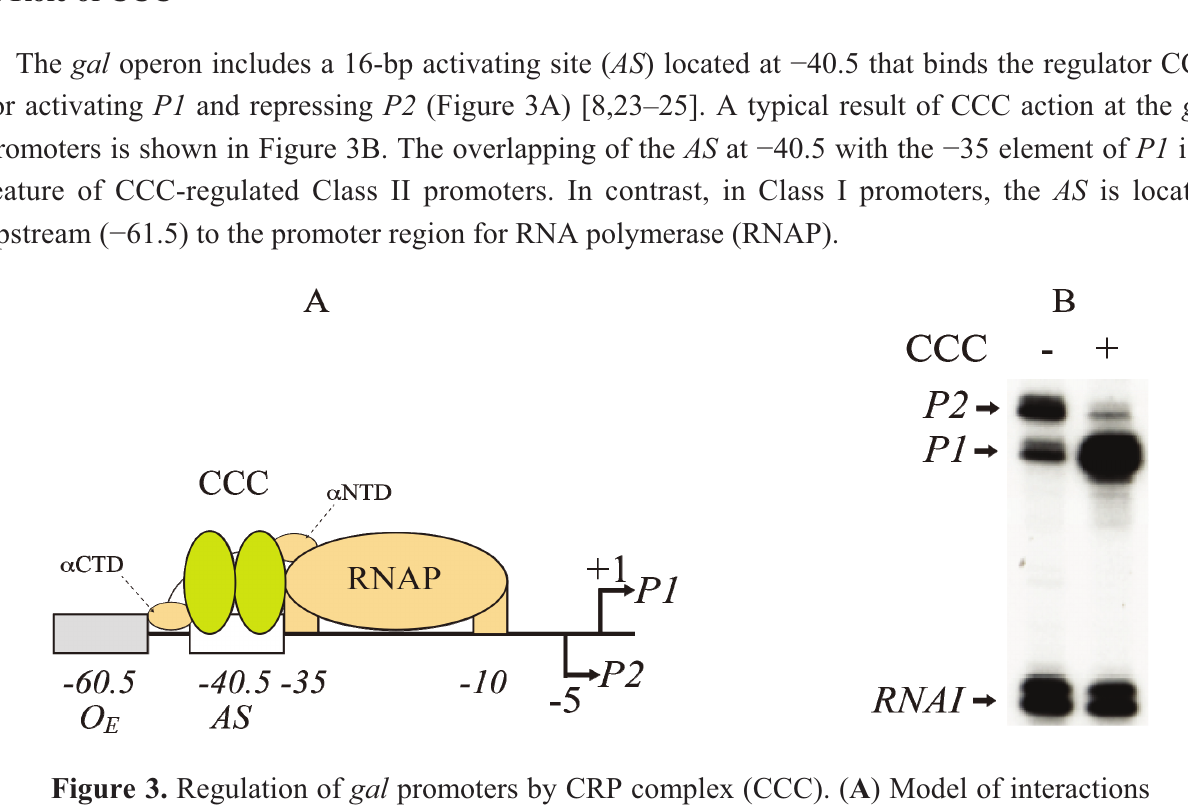
Figure 3. Regulation of gal promoters by CRP complex (CCC). ( A ) Model of interactions between CCC (yellow) at the activating site ((cid:2)40.5) and RNAP (brown) at the (cid:2)10 and (cid:2)35 elements of P1 (+1). P2 is located at (cid:2)5 The (cid:3)NTD and (cid:3)CTD of RNAP contact both subunits of Class II promoters at CCC as shown in Figure 4 (adapted from [25]); ( B ) RNAs made typically from P1 and P2 promoters in the absence ((cid:2)) and presence (+) of CCC as analyzed by gel electrophoresis. The concentrations of cAMP and CRP are 100 (cid:4)M and 50 nM, respectively. RNAI is a control RNA in the plasmid (reproduced with permission from Elsevier